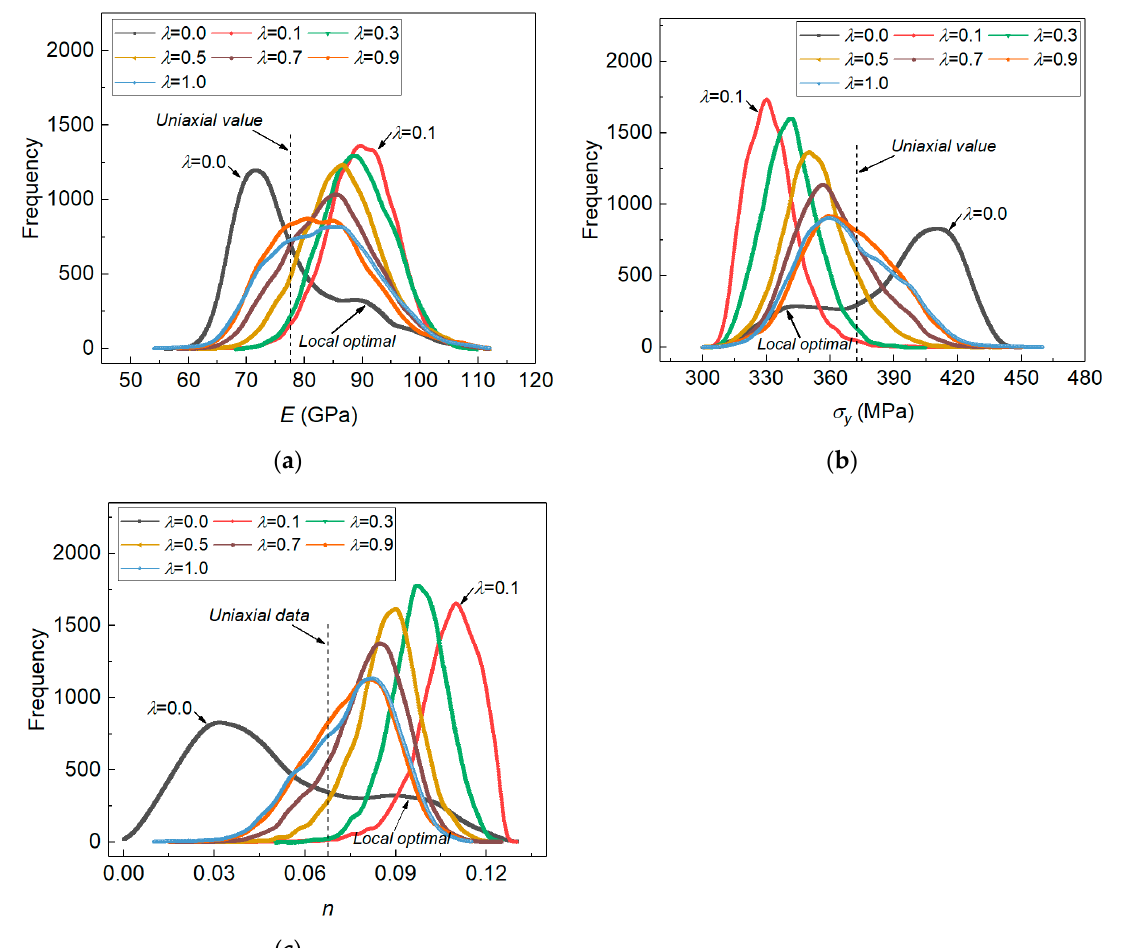
Figure 12. Influence of the weighting coefficient on posterior distribution results of elastoplastic properties, in ( a ) for E ; in ( b ) for σ y ; and in ( c ) for n